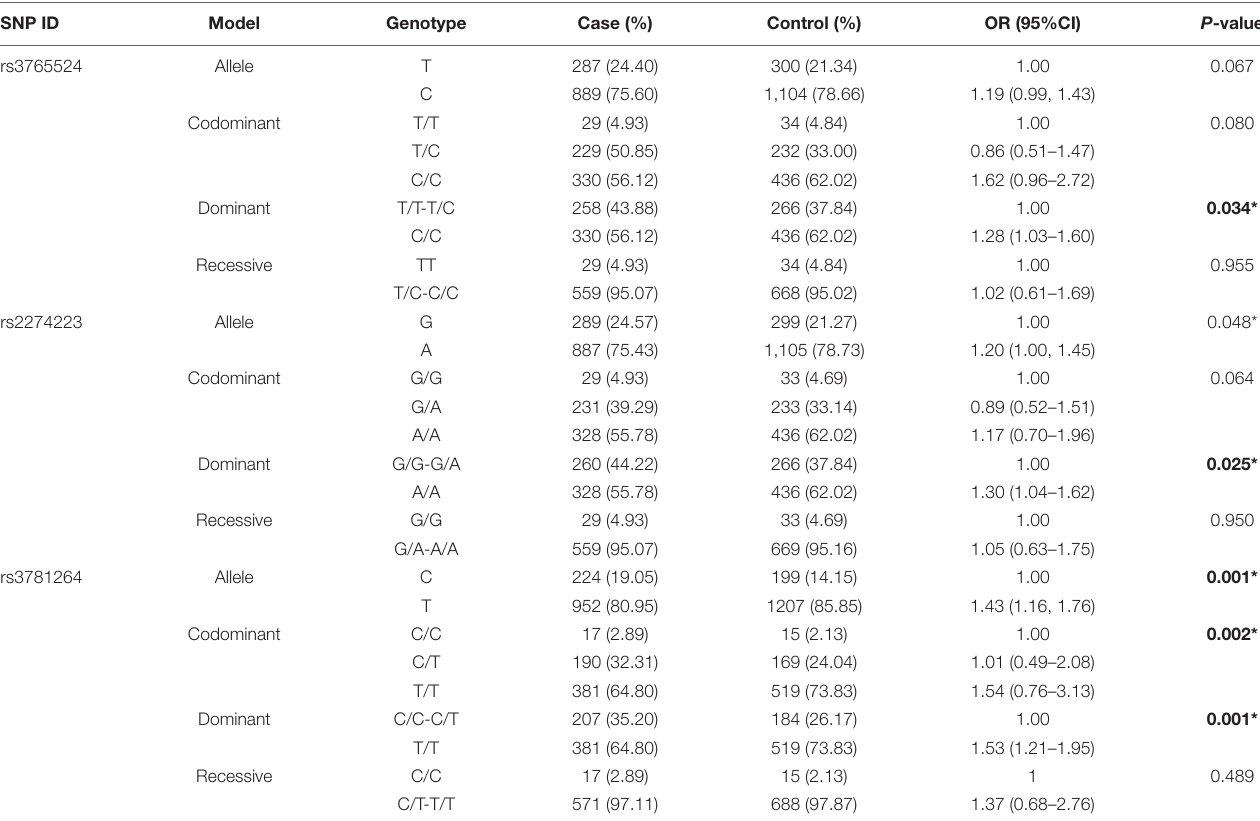
TABLE 3 | The relationships of five SNPs with gastric cancer according to the stratification adjusted by gender and